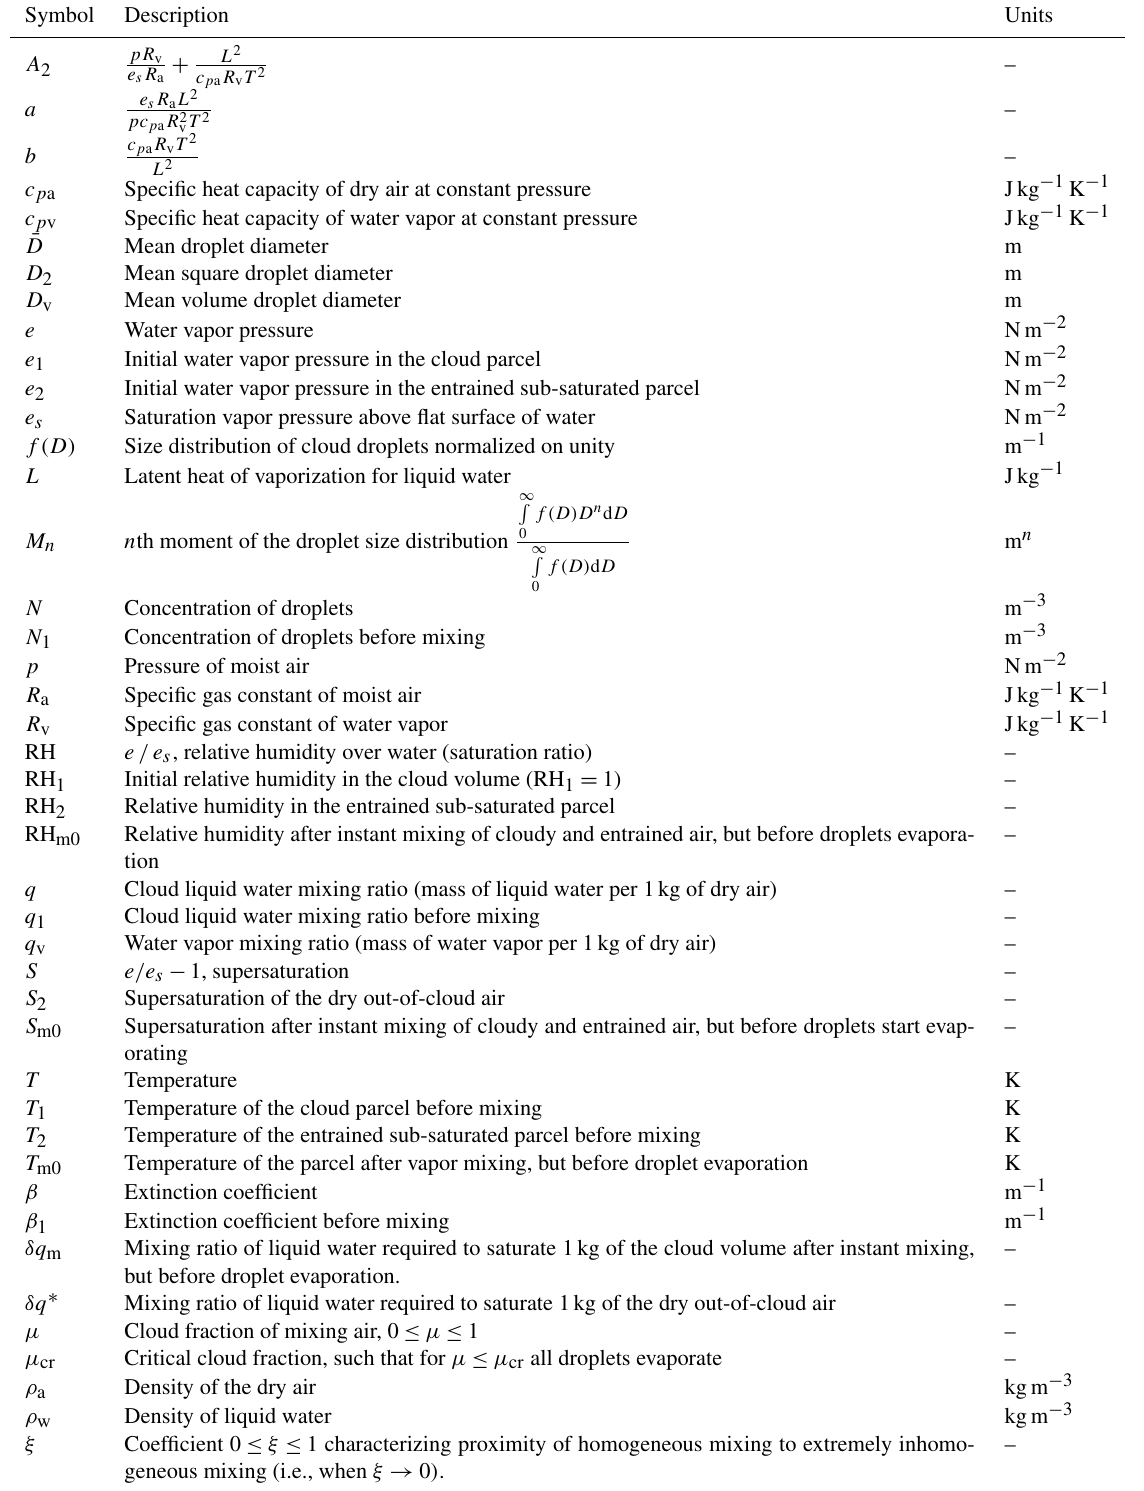
Table 1. List of